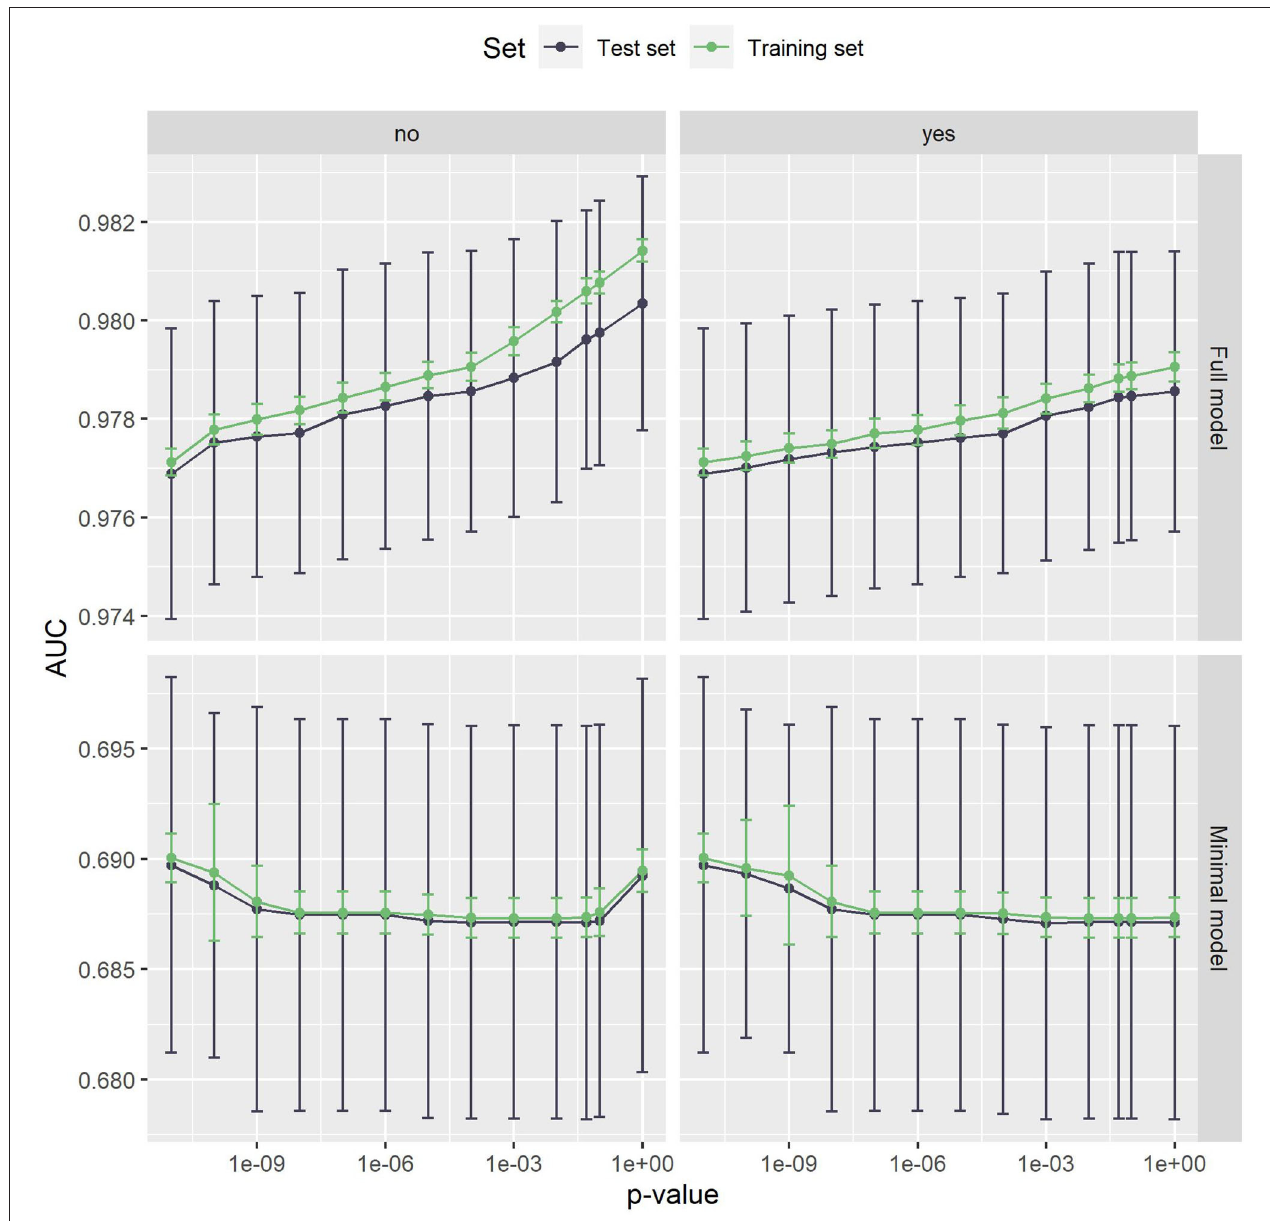
FIGURE 2 | The AUC values of the full model (top) and the minimal model (bottom). Error bars show one standard deviation, the color indicates whether the test or the training set was used. The left panel is without, the right panel with Bonferroni correction. The x-axis shows different p -values used in the filtering step. The leftmost dot denotes the p -value zero. The full model clearly outperforms the minimal model. Both models are very stable with respect to both the p -value threshold and Bonferroni correction.